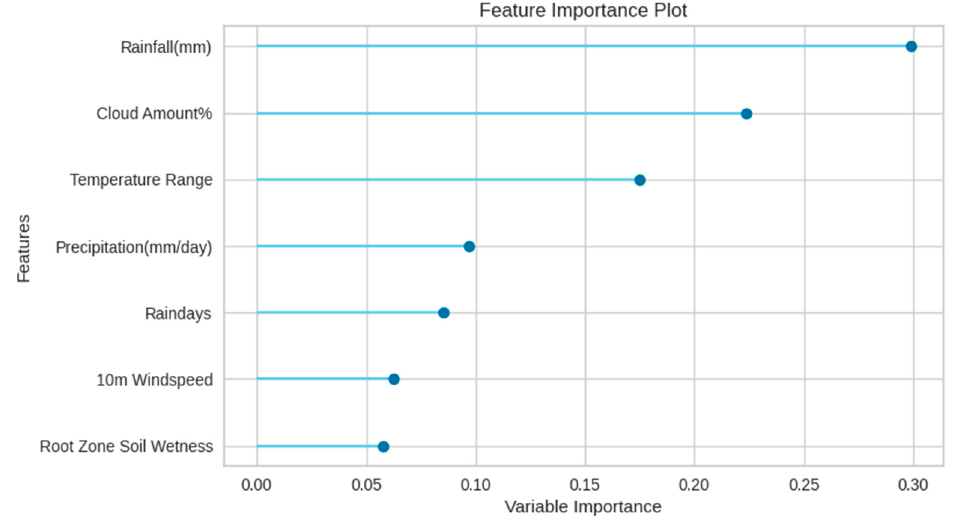
Figure 5. Feature importance plot of Extra Tree.